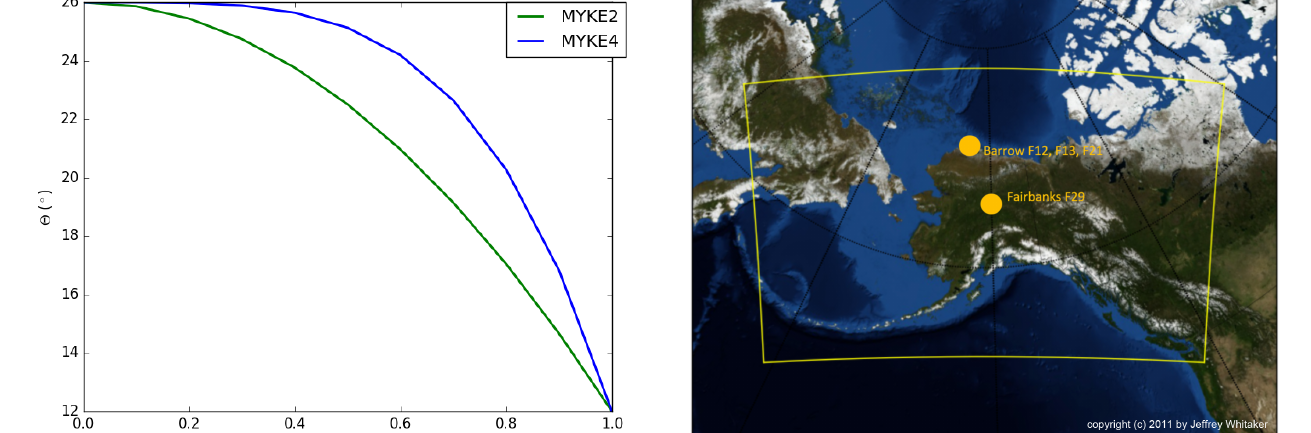
Figure 1. Variation of f n with θ for MYKE2 (blue line) and MYKE4 (green line).